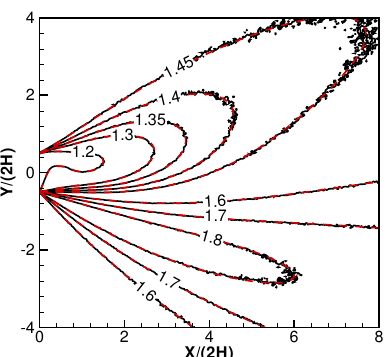
Figure 6. Nondimensional translational temperature contours for the jet/background mixture, n b / n 0 = 0.2, S 0 = 2.0, α 0 = 45 ◦ , S b = 1.0, T 0 = 200 Kelvin, and T b = 300 Kelvin. Red: analytical, black: DSMC.